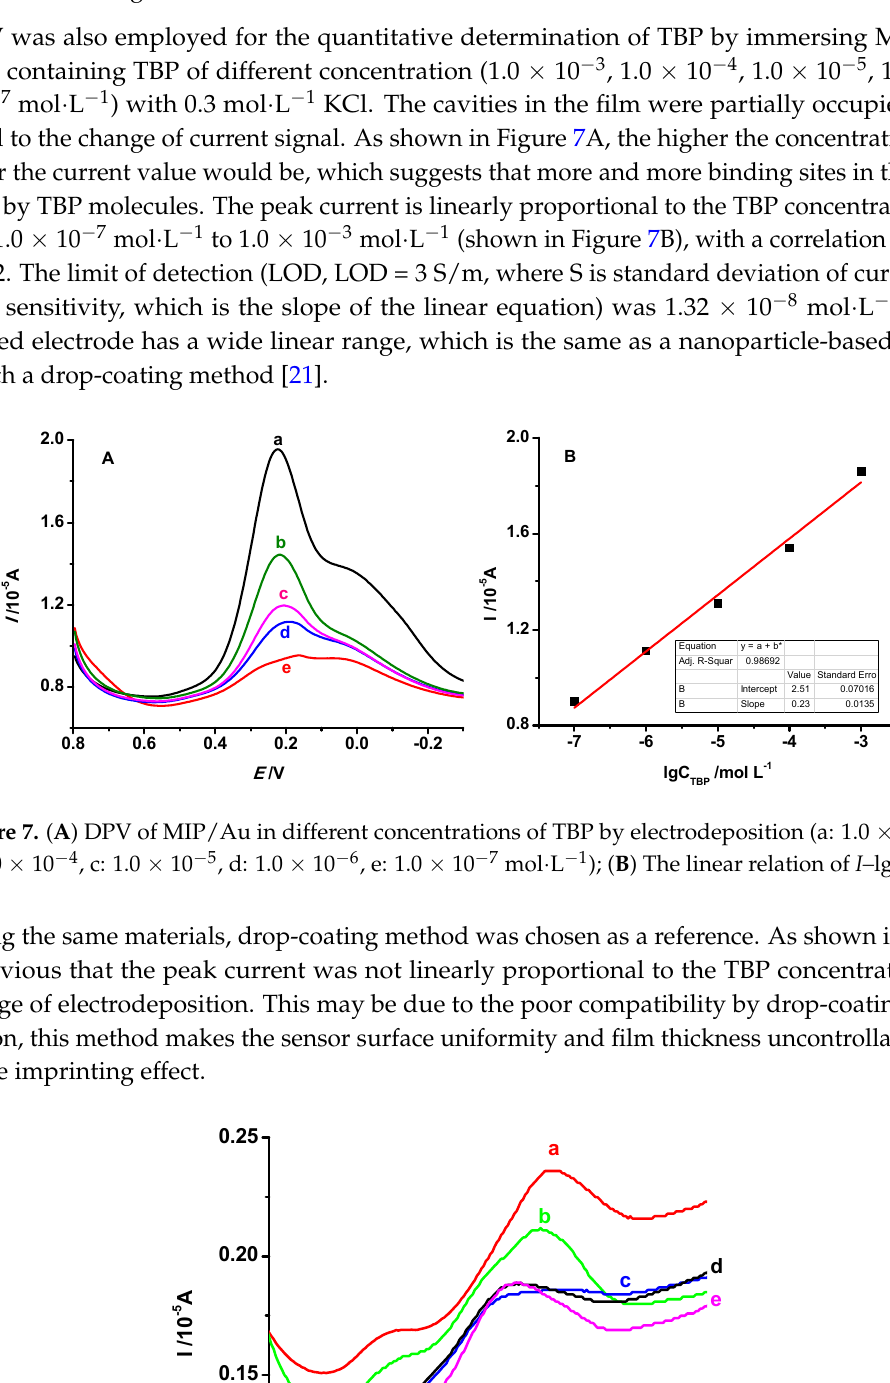
a Figure 9. The amperometric i – t curve of MIP/Au in different solutions: (a) TBP; (b) 4-methyl-phenol; (c) tert-butylhydroquinone. 3.5.4. Regeneration and Stability Regeneration is one of the most important properties for the application of the imprinted sensor. Therefore, the sensor was immersed in 0.5 mol·L − 1 H 2 SO 4 by shaking for 3 h, and back to the initial status. DPV was applied in solutions containing 5.0 × 10 − 3 mol·L − 1 TBP and 0.3 mol·L − 1 KCl. The cycle was repeated as described above. As shown in Figure 10, the current value of MIP/Au was much greater than NIP/Au, although the NIP/Au had almost no change. The current value of